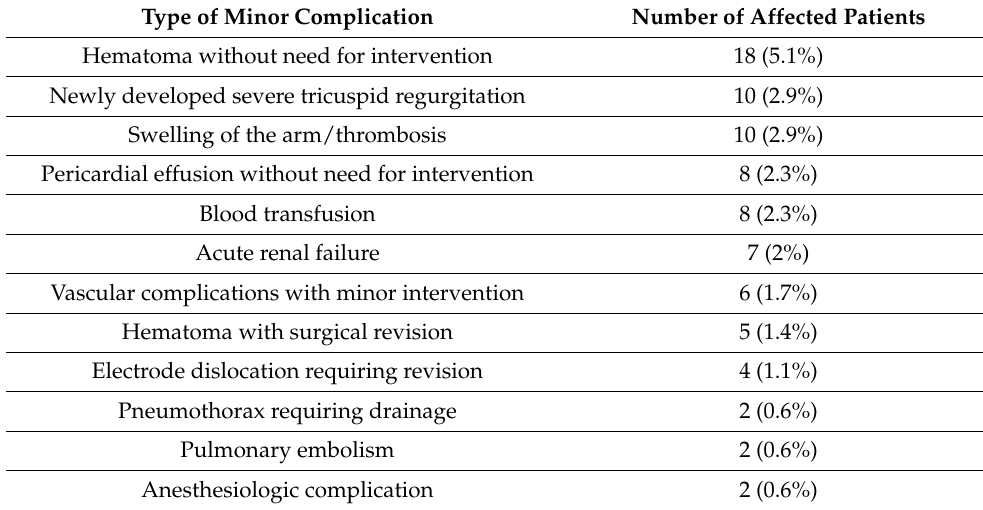
Table 5. Minor complications after transvenous lead